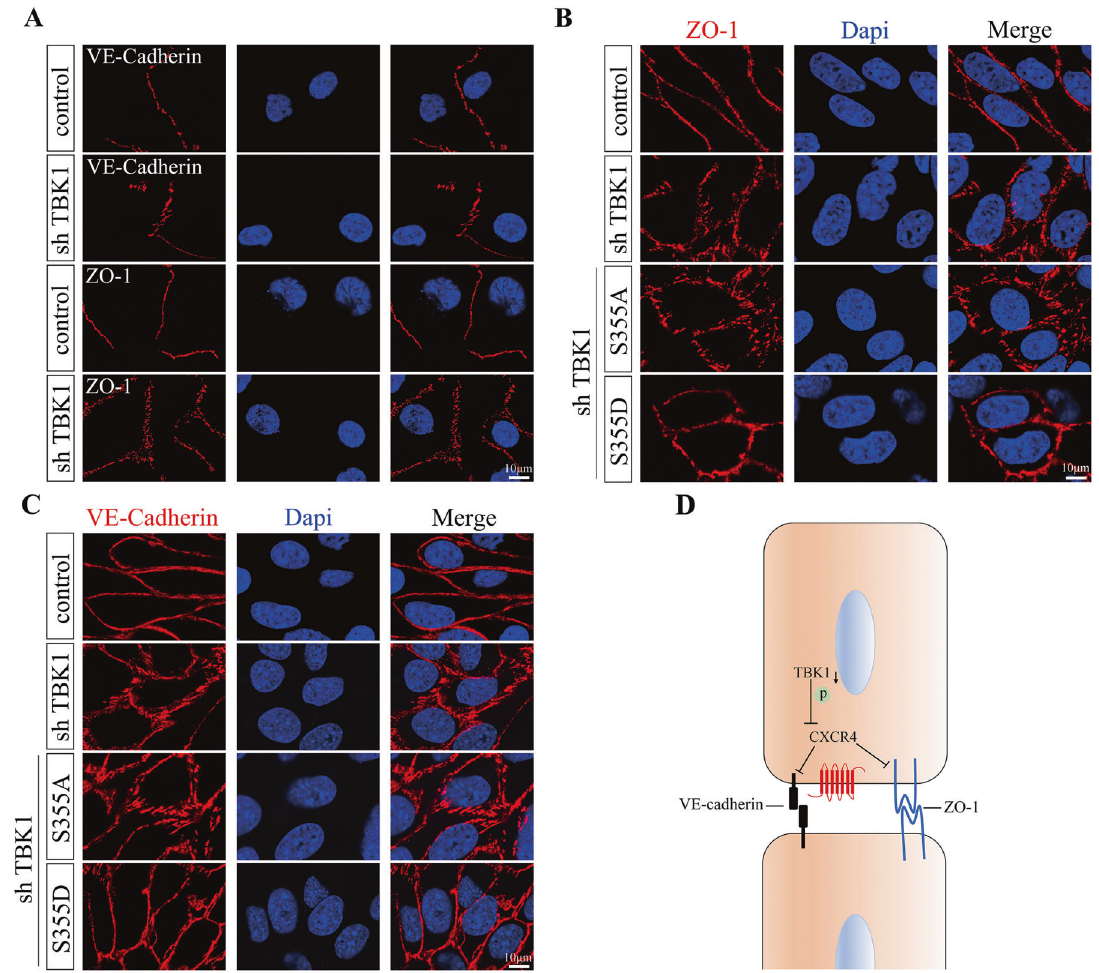
Fig. 6 Endothelial TBK1 knockdown disrupted the organization of junctional proteins. A Representative images of VE-cadherin and ZO-1 organization in HRCECs transfected with shTBK1. Three independent experiments were performed. B Representative images of ZO-1 organization in bEnd.3 cells transfected with shTBK1 or together with CXCR4 mutant plasmids (S355A or S355D). Three independent experiments were performed. C Representative images of VE-cadherin organization in bEnd.3 cells transfected with shTBK1 or together with CXCR4 mutant plasmids (S355A or S355D). Three independent experiments were performed. D Illustration of the role of TBK1-CXCR4 in endothelial